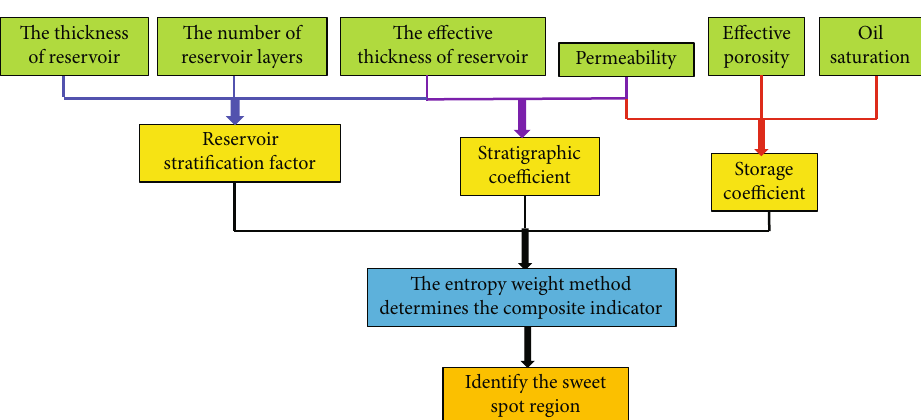
Figure 1: The sketch of the identi fi cation sweet spot region process in low-permeability reservoirs.